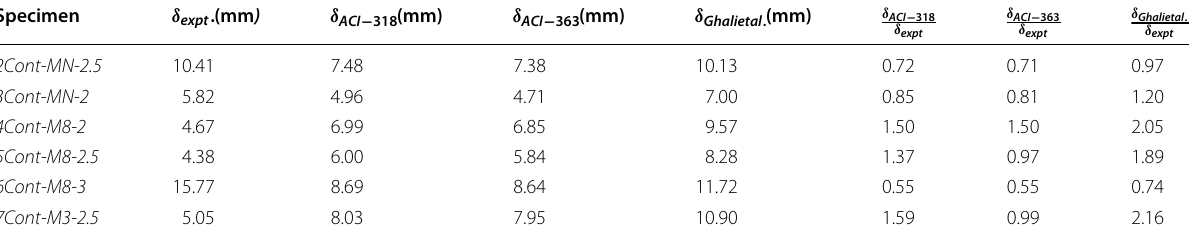
Table 5 Deflection predictions.